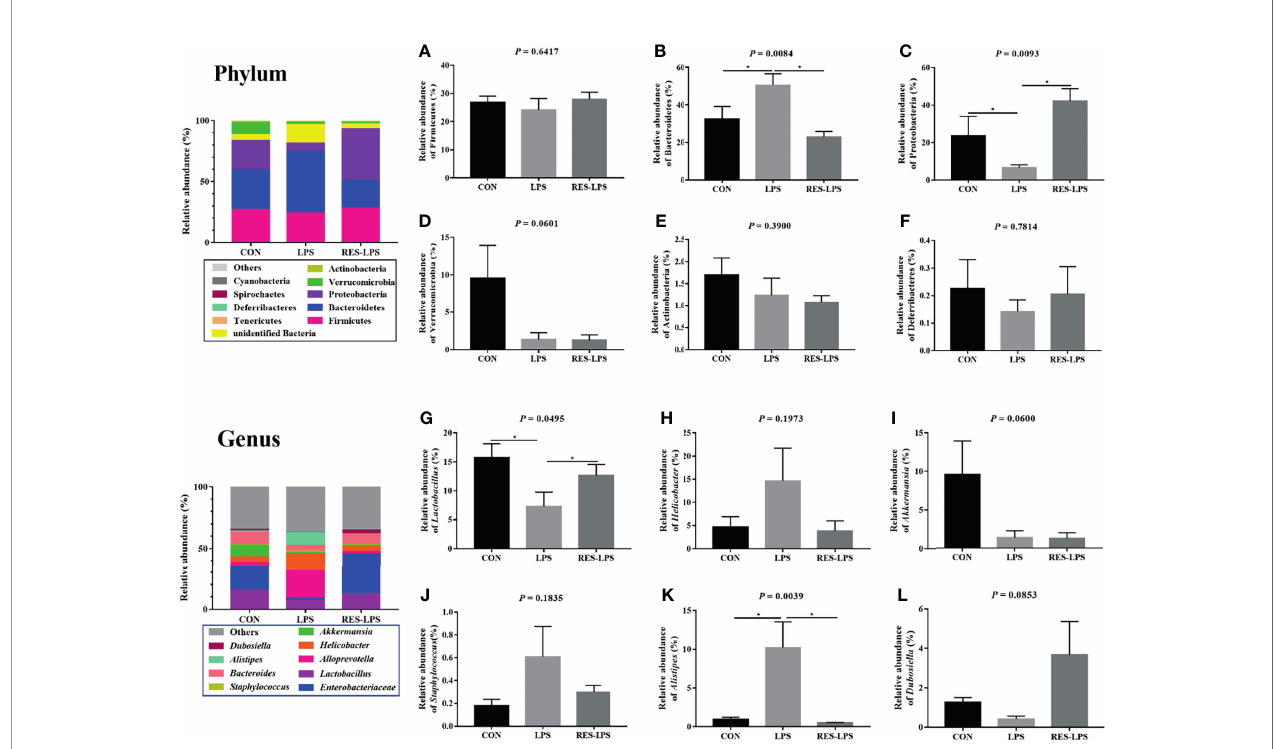
FIGURE 4 | Effects of RES on intestinal microbes during the development of in fl ammation induced by LPS. Relative abun-dances of the phyla Firmicutes (A) , Bacteroidetes (B) , Actinobacteria (C) , Verrucomicrobia (D) , Actinobacteria (E) , and Deferribacteres (F) . Relative abundances of the genera Lactobacillus (G) , Helicobacter (H) , Akkermansia (I) , Staphylococcus (J) , Alistipes (K) , and Dubosiella (L) in the three groups. * p < 0.05.